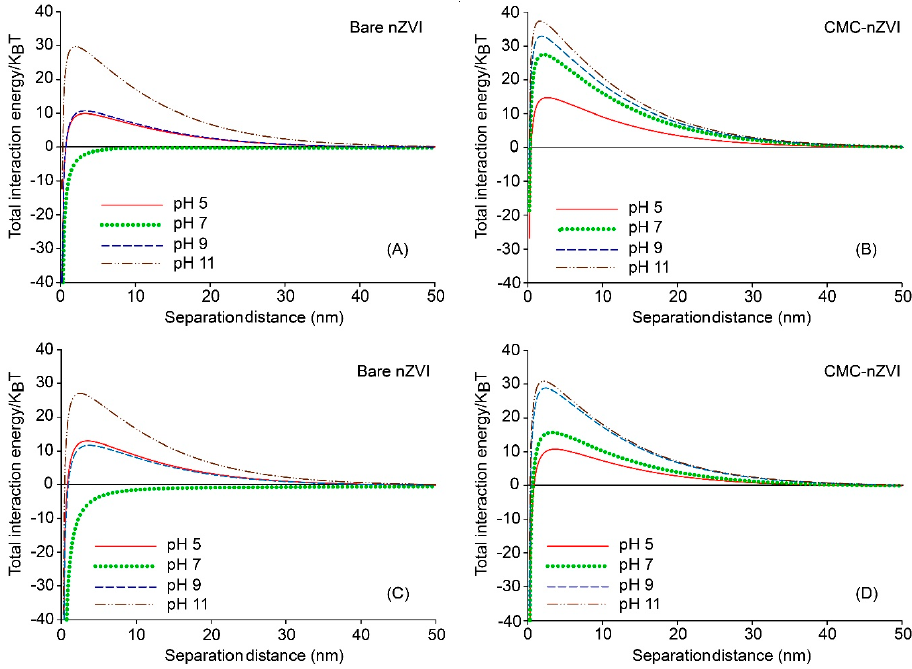
Figure 6. Effect of pH and CMC polymer stabilizer on the total interaction energy of 0.1 g L − 1 (A,B) and 1.0 g L − 1 (C,D) nZVI particle suspensions in 1 mM NaHCO 3 . The maximum energy barrier occurred at pH 11 and reached 29.7 and 37.4 𝐾 (cid:3003) 𝑇 for the 0.1 g L − 1 bare and CMC–nZVI, respectively. For the 1.0 g L − 1 bare and CMC–nZVI, the maximum energy barrier was slightly less and reached 27.1 and 30.9 𝐾 (cid:3003) 𝑇 , respectively (Figure 6). In general, the energy barrier decreased with decreasing pH for the 0.1 g L − 1 CMC–nZVI nanoparticles and reached 32.8, 27.5, and 14.7 𝐾 (cid:3003) 𝑇 at pH 9, 7, and 5, respectively. For the 0.1 g L − 1 bare nZVI nanoparticles, the energy barrier decreased with decreasing pH and reached 10.7 and 9.9 𝐾 (cid:3003) 𝑇 at pH 9 and 5, respectively. The decrease in the energy barrier with decreasing pH was slightly larger for the 1.0 g L − 1 CMC–nZVI nanoparticles and reached 28.8, 15.7, and 10.8 𝐾 (cid:3003) 𝑇 at pH 9, 7, and 5, respectively. For the 1.0 g L − 1 bare nZVI nanoparticles, the energy barrier decreased at pH 9 and 5 to 11.7 and 12.9 𝐾 (cid:3003) 𝑇 , respectively (Figure 6).